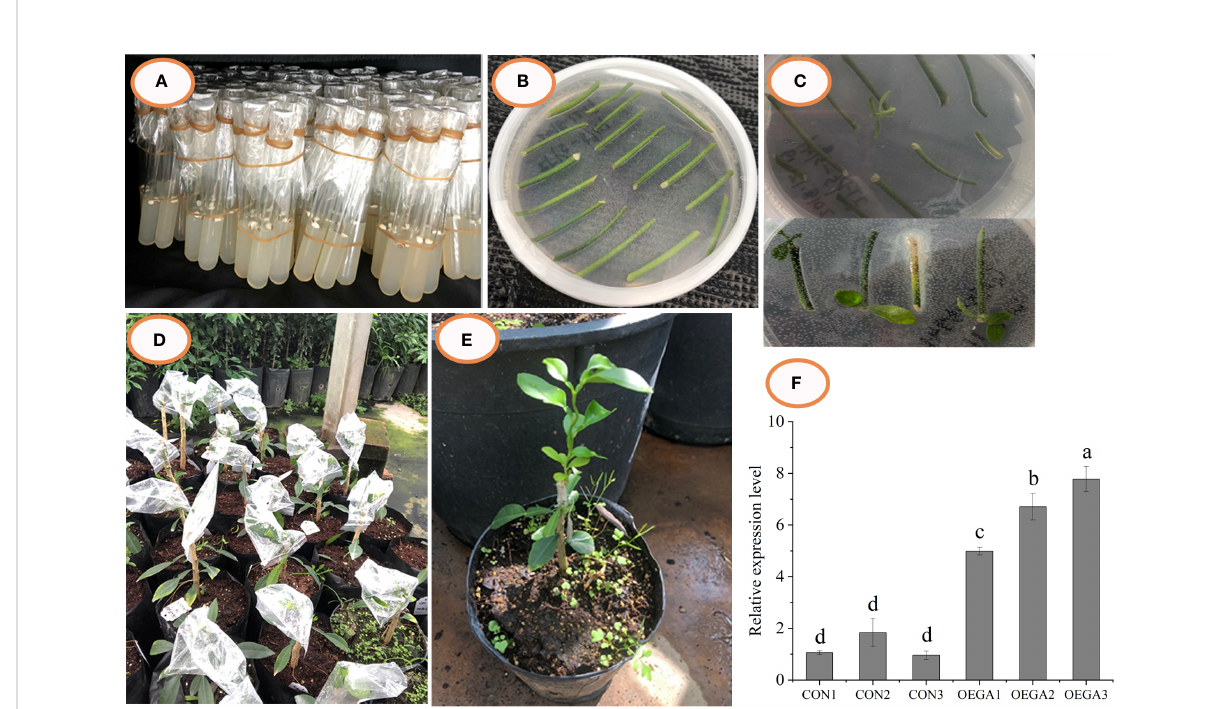
FIGURE 1 Transgenic citrus plants overexpressing CcGASA4 were obtained through genetic transformation. (A – E) Process of Agrobacterium -mediated CcGASA4 genetic transformation. (A) citrus seeds were sown on MS medium; (B) dark culture; (C) light culture; (D) grafted resistant buds on rootstocks; (E) surviving resistant buds. (F) qRT-PCR analysis of CcGASA4 expression in the OEGA lines. Data are presented as the mean ± standard error (SE) of three qRT-PCR experiments. Different lowercase letters (a – d) on the bars indicate statistically-signi fi cant differences ( P < 0.05) based on Duncan ’ s LSD multiple range